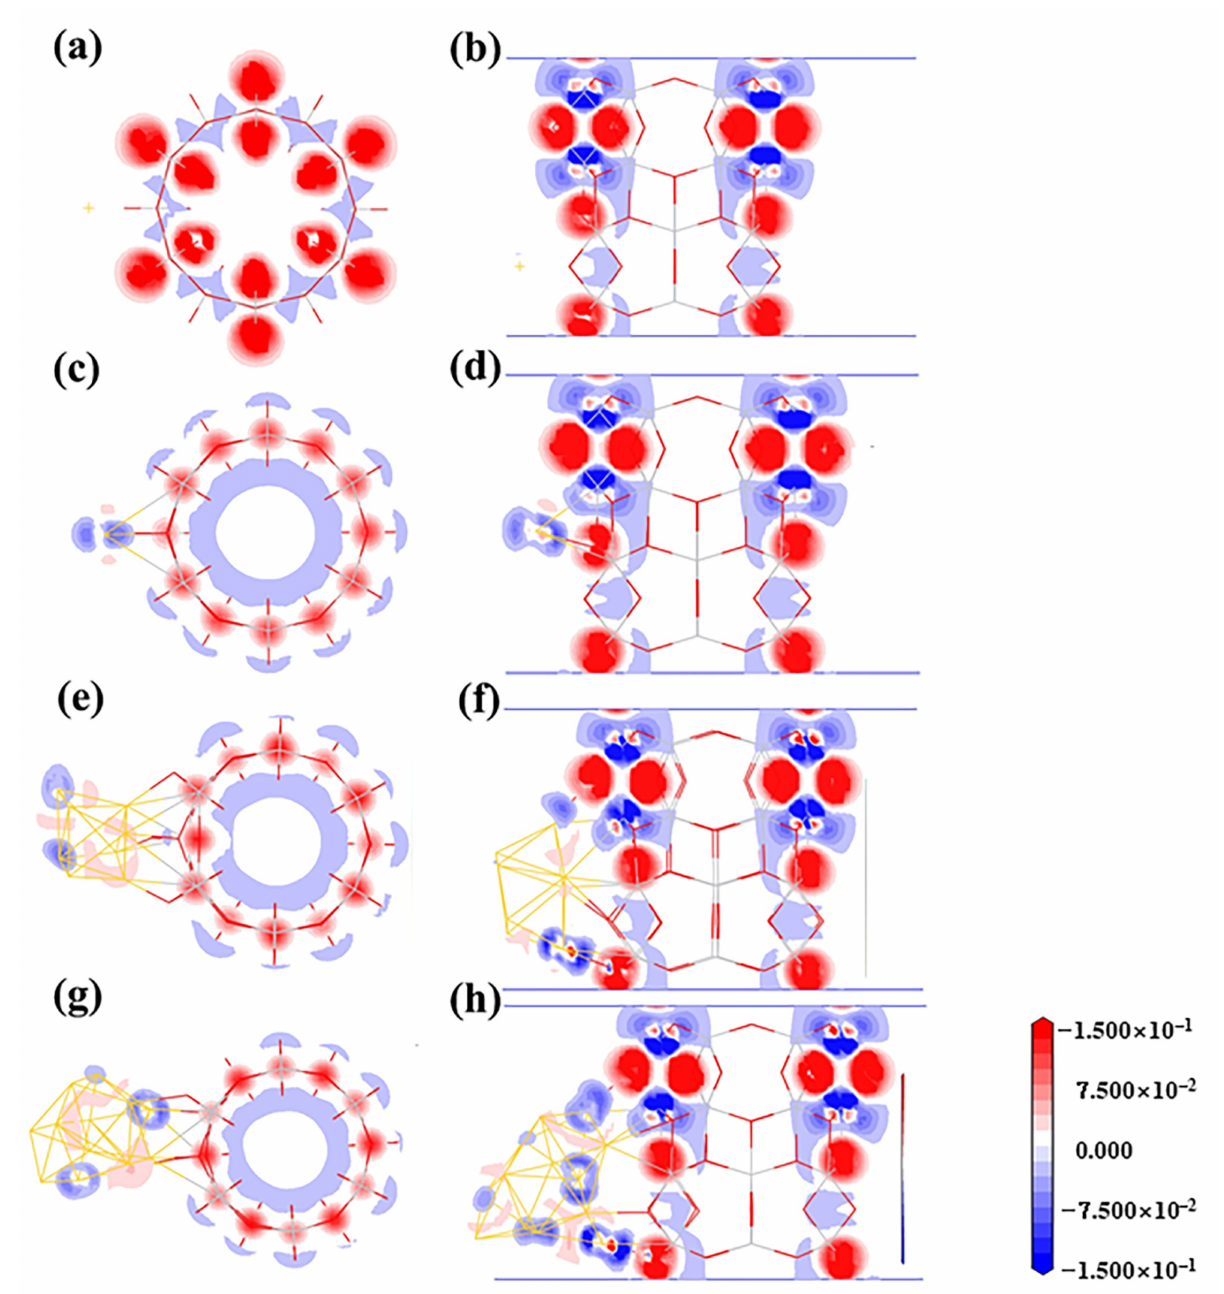
Figure 5. Deformation density contour maps for the adsorption of Au n clusters on the TiO 2 NT (6,0) surface. The configurations are as follows: ( a , c , e , g ) are the cross-sectional views of Au 1(O,O) , Au 1(O,Ti) , Au 8-C, and Au 13-B , respectively; ( b , d , f , h ) are the side views of Au 1(O,O) , Au 1(O,Ti) , Au 8-C, and Au 13-B , respectively. Contour level is − 0.015~0.015 au. In this plot, a loss of electrons is indicated in blue, while electron enrichment is indicated in